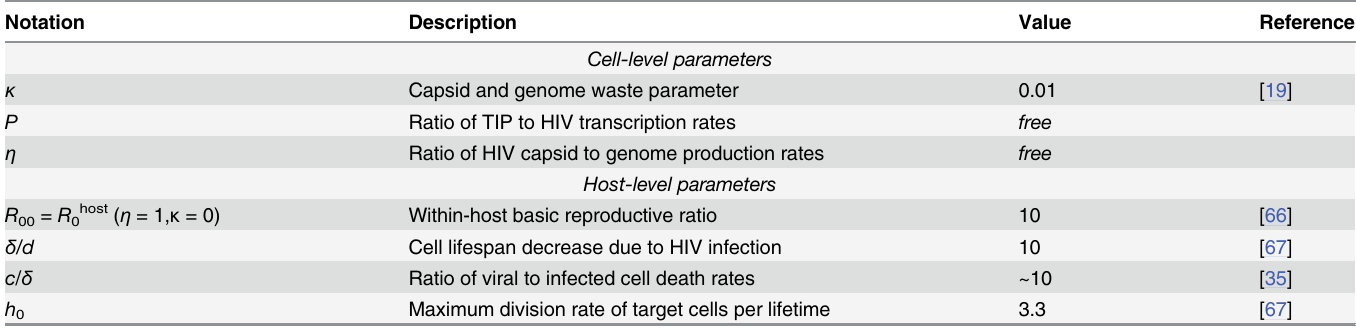
Table 2. Cell-level and host-level parameters * .